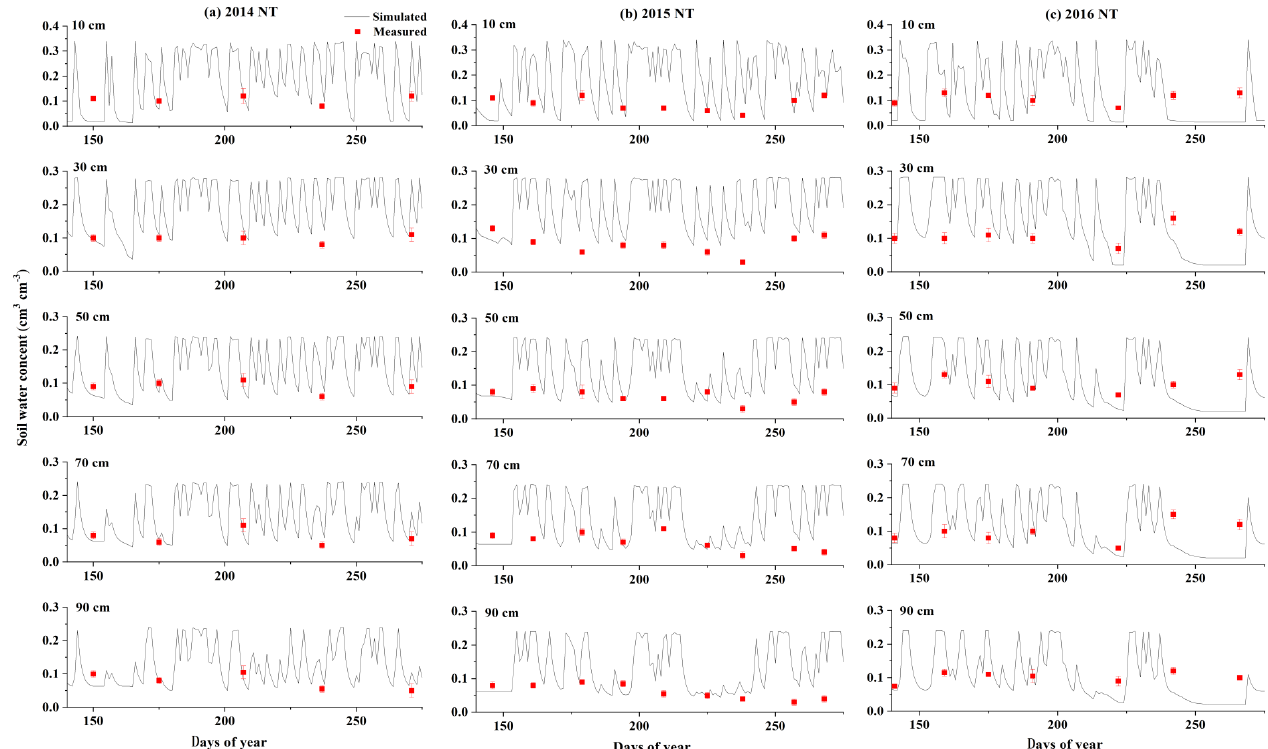
Figure 5. Measured and simulated soil water contents for CT at different soil depths during 2014‒ 2016.